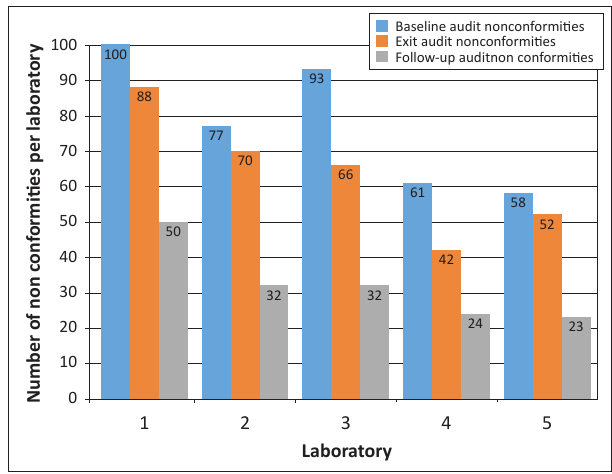
FIGURE 4: Change in number of nonconformities per laboratory over time.